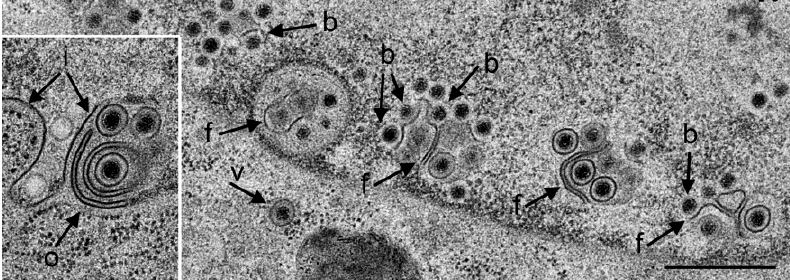
Figure 1. TEM of a Vero cell 12 hpi with R7041(∆Us3). Many capsids are at the